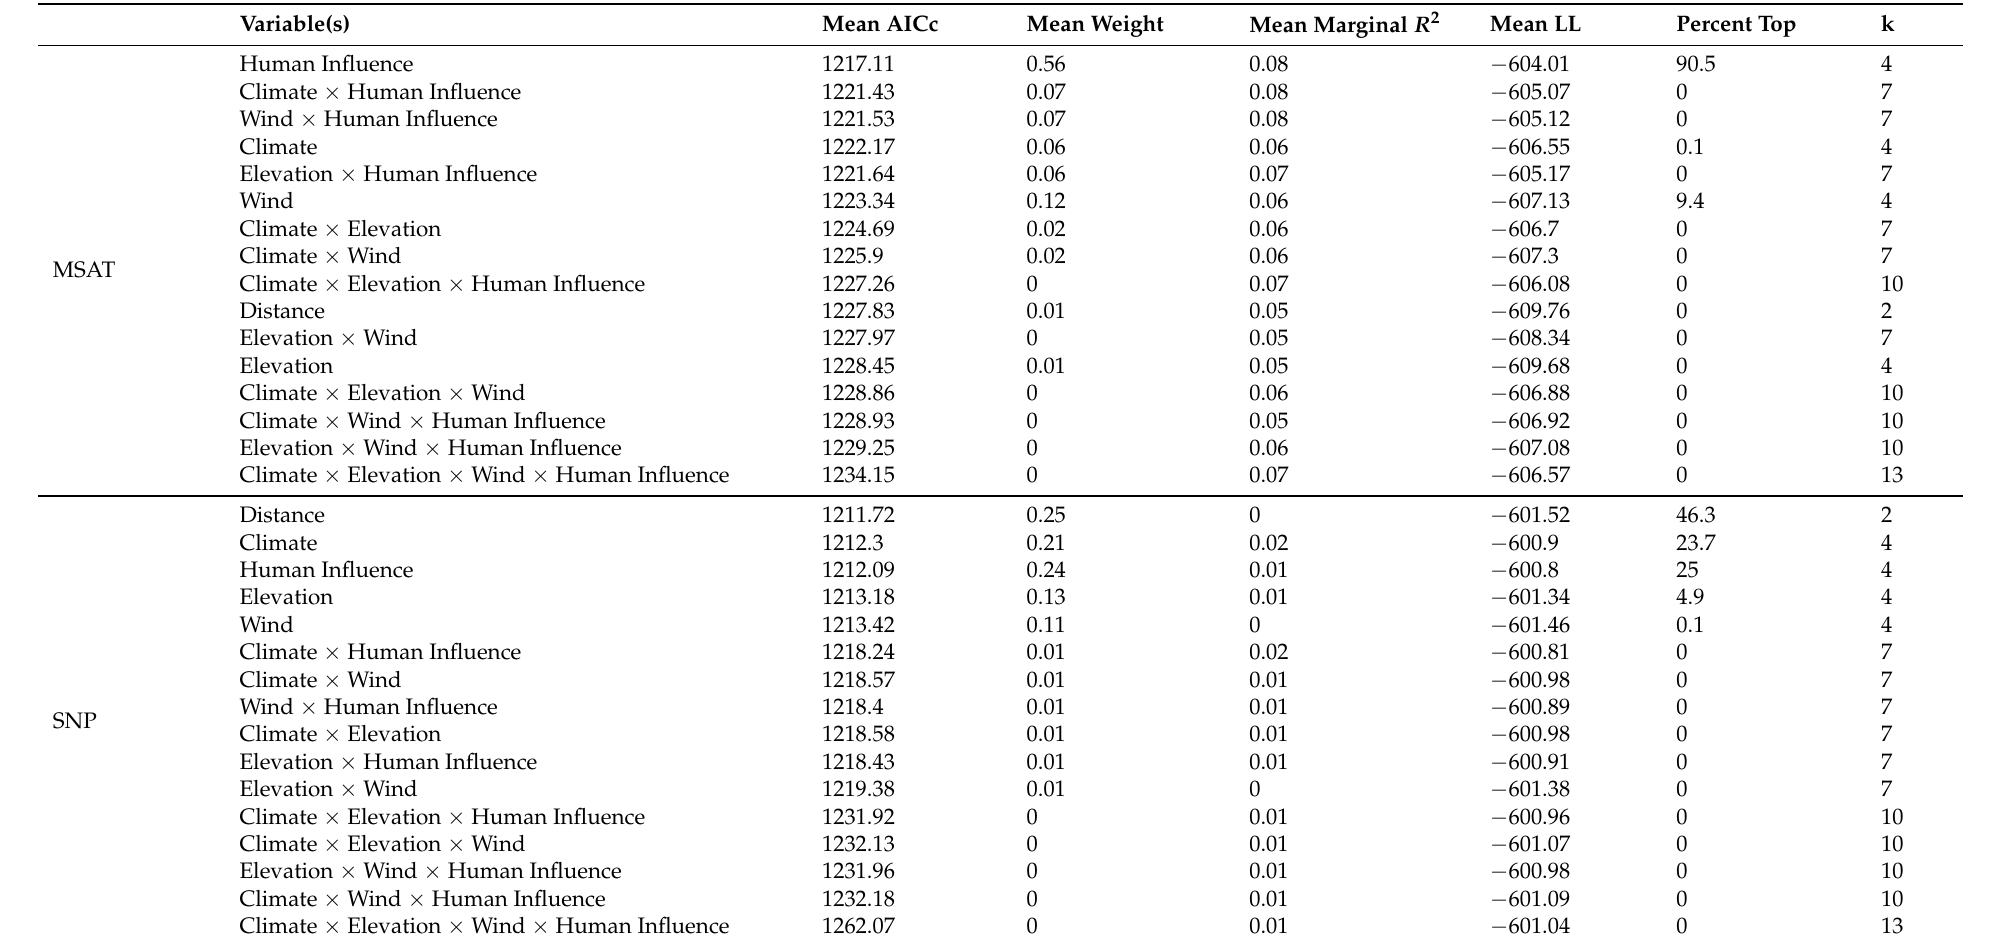
Table 3. Assessment of environmental variables contributing to P. destructans genotype distributions across landscape. Using a maximum likelihood population effects mixed-model, we measured the effects of various environmental variables/resistance surfaces to predict changes in pairwise genetic differences (PCA scores) generated from microsatellite or SNP alleles. AICc: adjusted Akaike information criterion; weight; marginal R 2 values of the fitted MLPE model. LL: log likelihood; Percent Top: the percentage of times each model was the best-fit model in over 1000 bootstrap